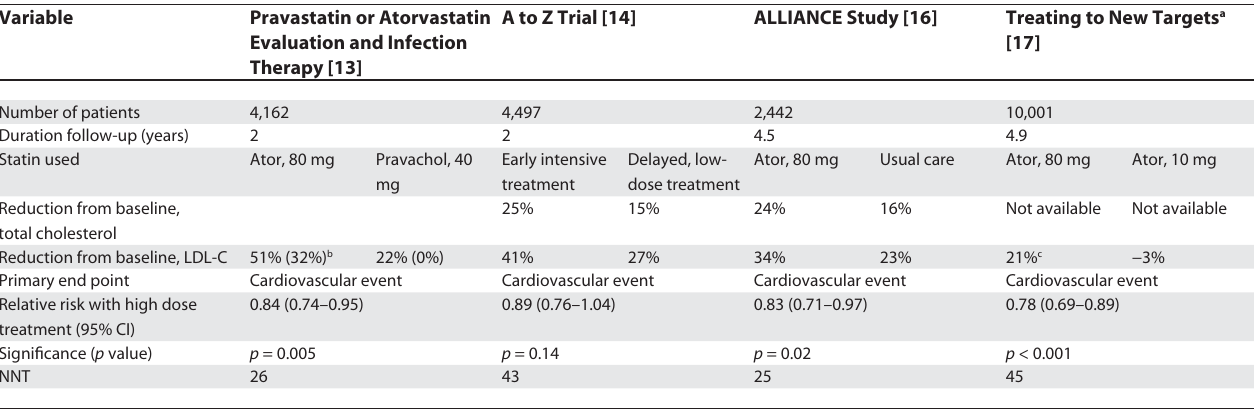
Table 3. Statin Trials Comparing High-Dose with Low-Dose